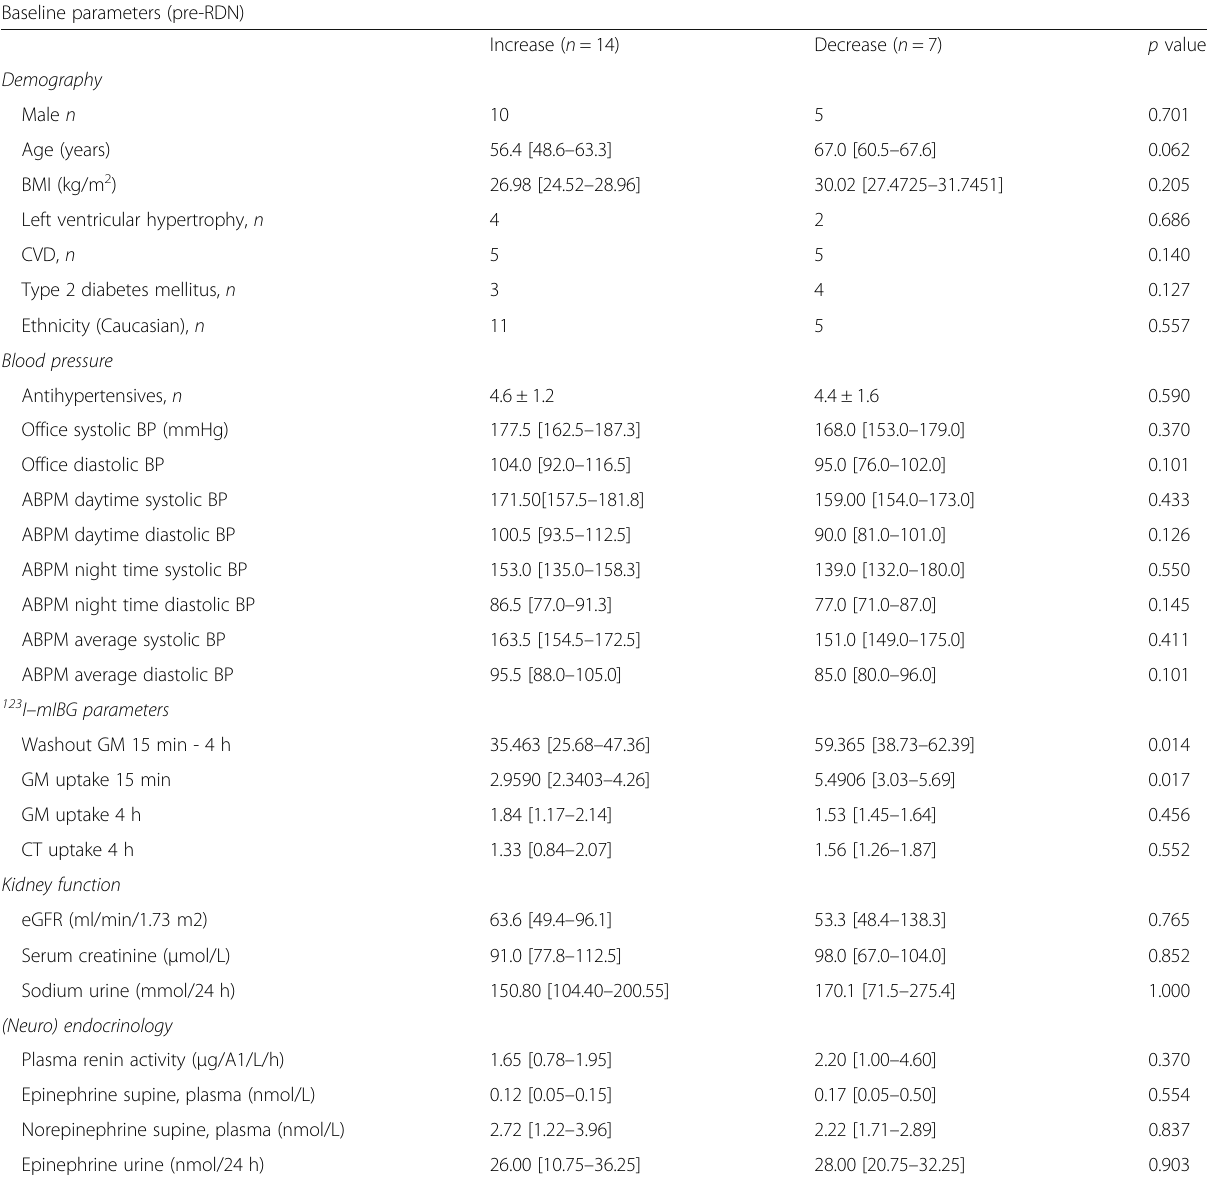
Table 4 Parameters pre-RDN in patients with a positive delta (i.e., increase in 123 I – m IBG uptake at 15 min) versus patients with a negative delta (i.e., decrease in 123 I – m IBG uptake at 15 min) after RDN Baseline parameters (pre-RDN) Increase ( n =